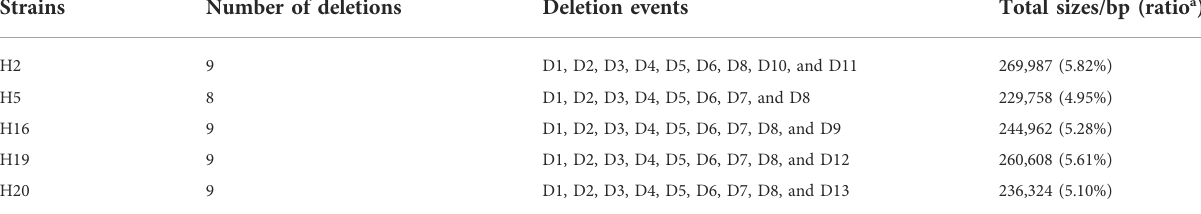
TABLE 2 The genomic deletions of the fi ve selective mutants.